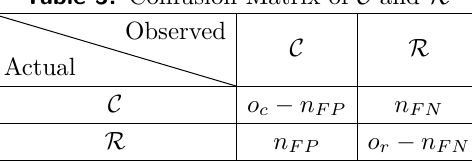
Table 5: Confusion Matrix of C and R